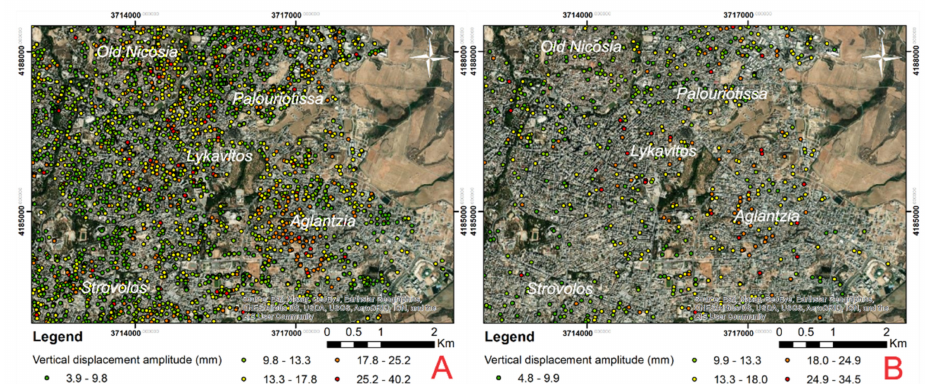
Figure 5. Spatial distribution of the vertical displacement amplitude for the period 16 November